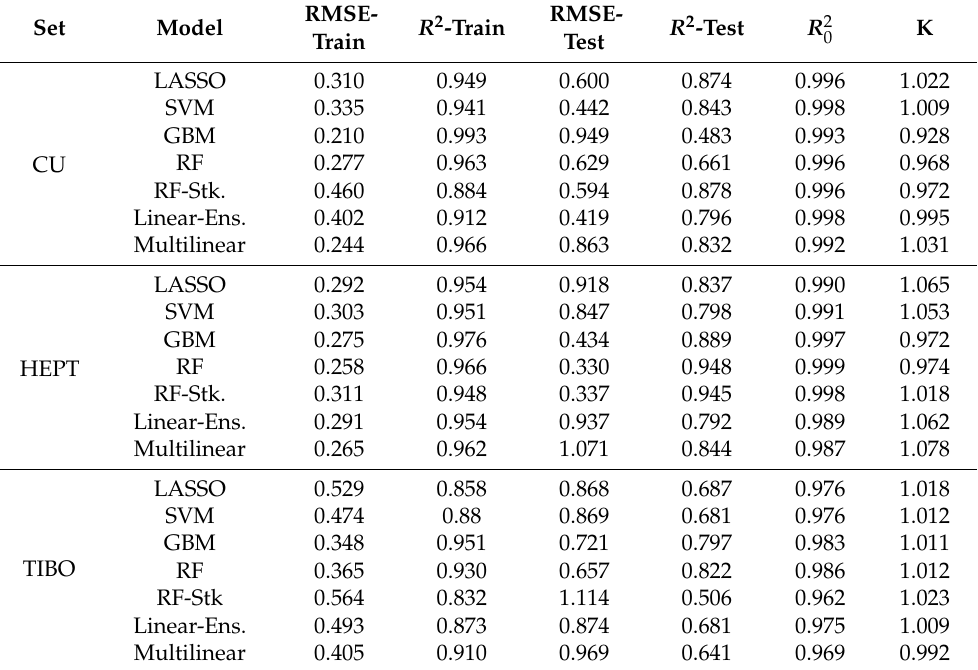
Table 3. The values of observed statistical parameters for each model generated for the prediction of anti-HIV activity. See Supplementary files for further